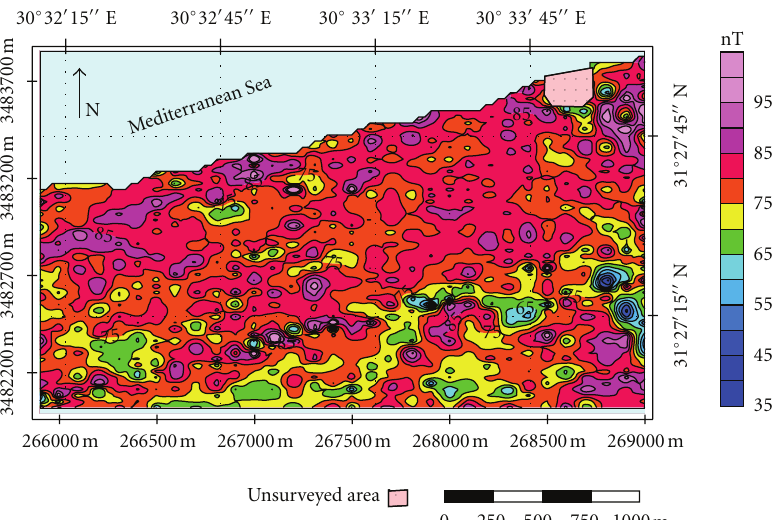
Figure 3: Filled colour contour map of the total magnetic intensity of Koam Mashaal area, East Rosetta, Mediterranean Sea Coast, Northern Egypt.